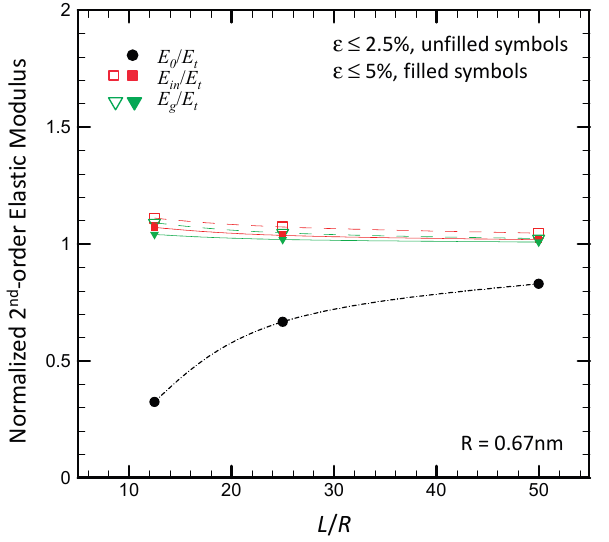
Figure 10. Second-order elastic modulus (displayed as E varying L / R determined under free standing indentation by MM simulations. E modulus determined by fitting the strain energy density as Equation (7), in which the vdW effect is